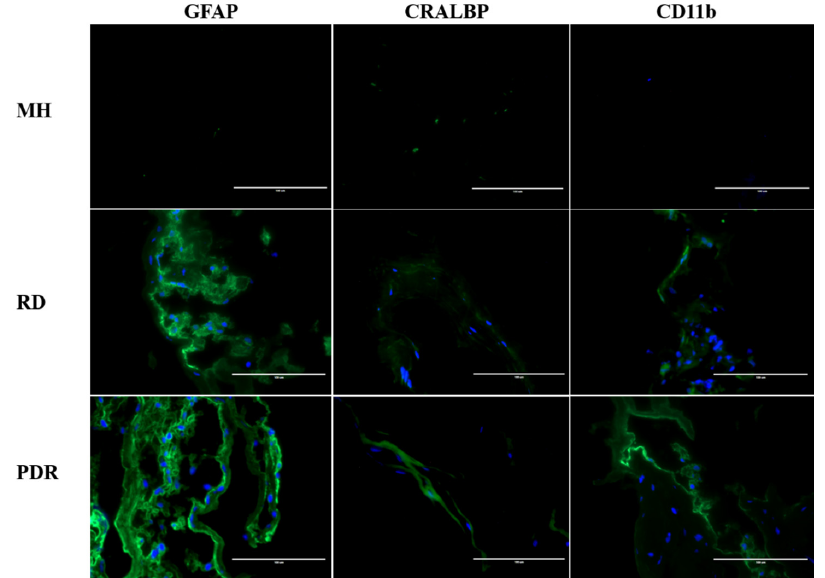
Figure 3. Representative images showing IHC of membranes from pathological conditions MH, RD and PDR with intense cytoplasmic and membranous expression of GFAP, CRALBP, and CD11b proteins. (Scale bar; 100 μ m).